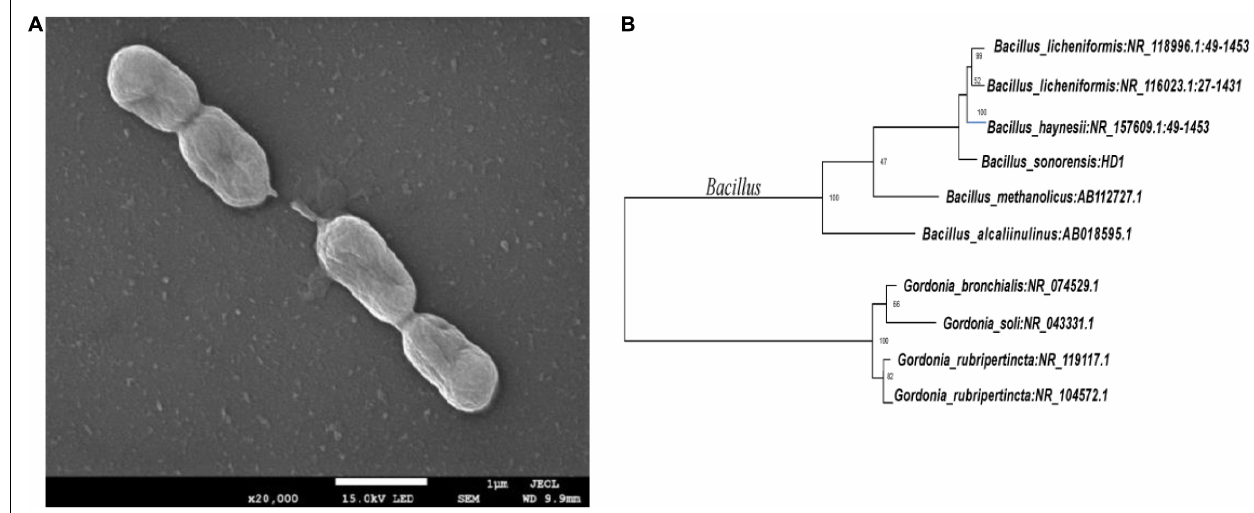
FIGURE 2 | (A) Scanning Electron Microscope image of HD1 and (B) Phylogenetic tree based on 16S rRNA sequence highlighting the phylogenetic position of HD1.